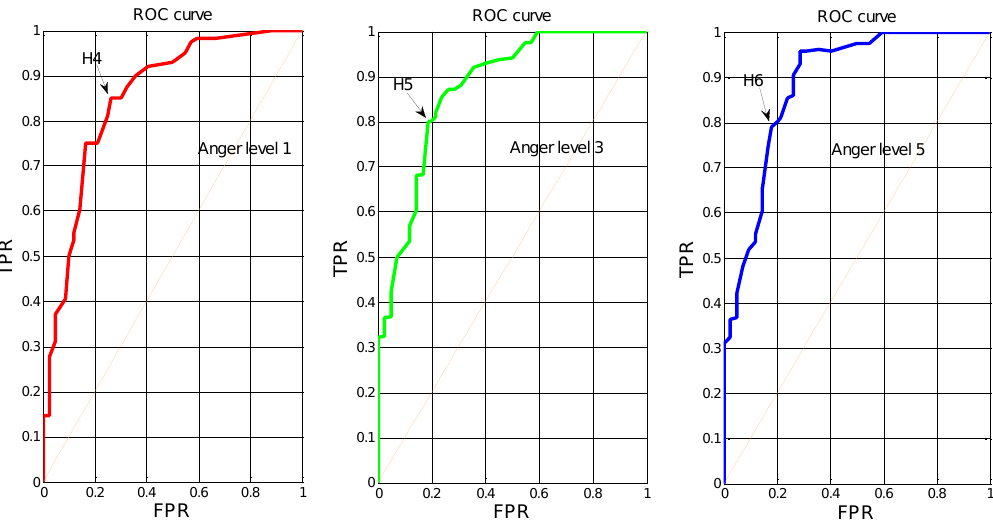
Figure 9. ROC curve of θ% at low, moderate and high anger level state. Table 3. Best cut-off point (optimal threshold) for indicator θ% and β% at different anger level.